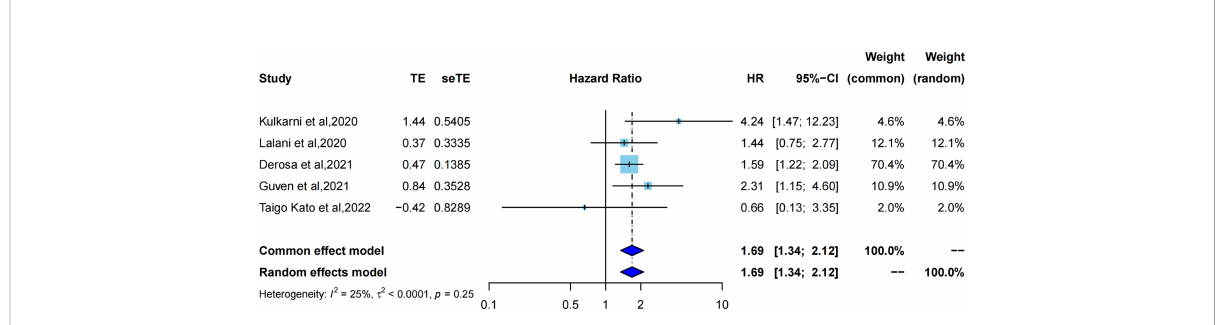
FIGURE 3 Forest plot of hazard ratios for overall survival of RCC patients exposed to antibiotics versus not exposed to antibiotics around